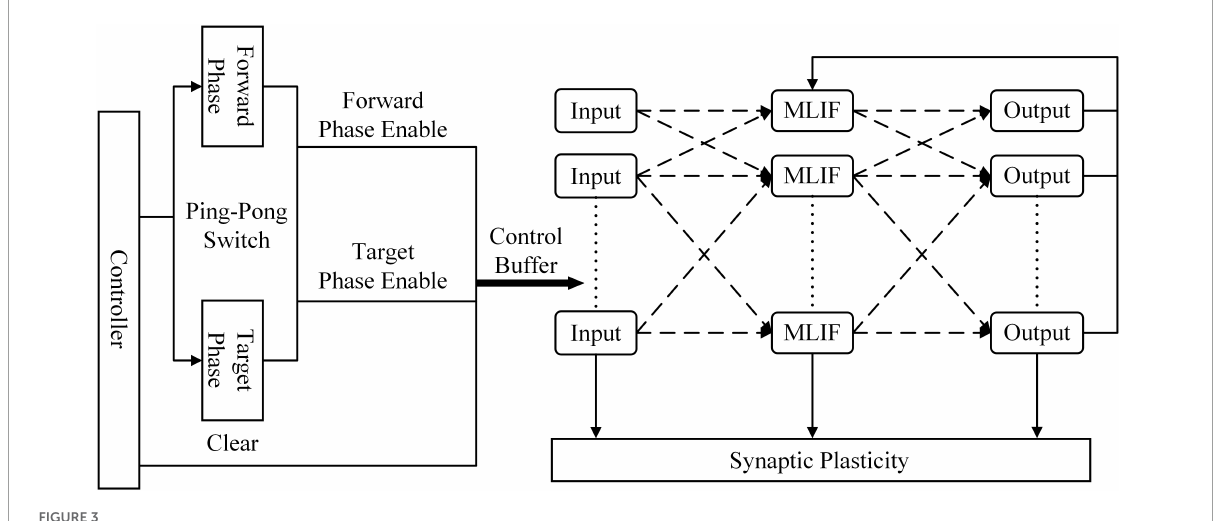
FIGURE3 Overview of the spiking neural network (SNN) architecture implemented on the field-programmable gate array (FPGA). The controller is used as a system clock counter and enables signals. The ping-pong switch controls enable signals for the forward phase and target